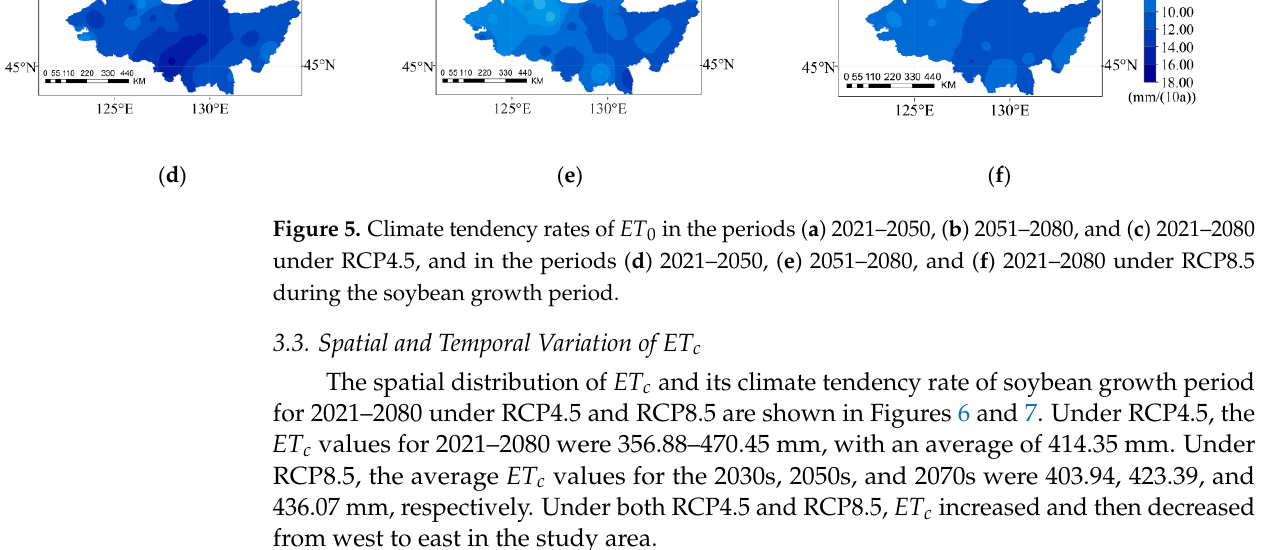
Figure 5. Climate tendency rates of ET 0 in the periods ( a ) 2021–2050, ( b ) 2051–2080, and ( c ) 2021– 2080 under RCP4.5, and in the periods ( d ) 2021–2050, ( e ) 2051–2080, and ( f ) 2021–2080 under RCP8.5 during the soybean growth period.